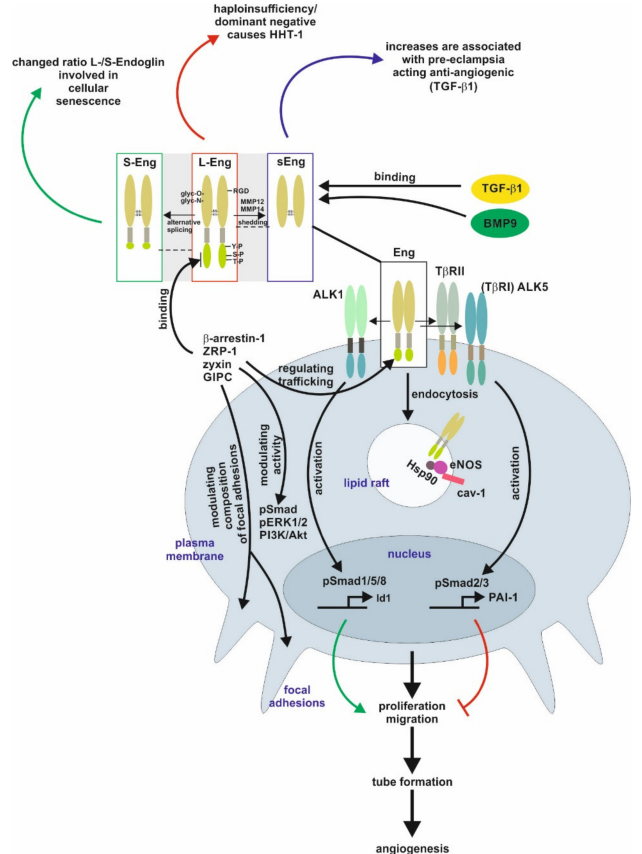
Figure 1. Endoglin biology in endothelial cells. (central part) Endoglin (Eng) is a component of a receptor complex in endothelial cells comprising the type I receptor dimers activin receptor-like kinase 5 (ALK5) or ALK1, and type II receptor dimers binding ligands, e.g., transforming growth factor- β 1 (TGF- β 1) and bone morphogenetic protein 9 (BMP9), of the TGF- β -superfamily. Interaction with these receptors either activates Smad1 / 5 / 8 or Smad2 / 3 signaling (phosphorylation) to regulate corresponding target genes, e.g., inhibitor of di ff erentiation 1 (Id1) and plasminogen activator inhibitor-1 (PAI-1), and finally, cellular responses including proliferation and migration to balance the activation and resolution phase of angiogenesis. Localization of Eng in caveolin-1 (cav-1) positive lipid rafts mediates interaction of heat shock protein 90 (Hsp90) with endothelial NO-synthase (eNOS) regulating its function. (upper part) Beside the long variant of Eng (L-Eng), a C-terminally truncated, shorter splice variant (S-Eng) and a shedded form, mediated by matrix metalloproteinase (MMP)-14, comprising only the extracellular domain (sEng) has been identified. All three variants of Eng are involved individually in cellular (senescence) and pathological conditions (e.g., HHT-1, pre-eclampsia), respectively. The extracellular domain of Eng is N - and O -glycosylated and human Eng contains an integrin binding motif (RGD) motif. The L-Eng C-terminal domain is a substrate for TGF- β receptors leading to serine / threonine phosphorylation. Tyrosine phosphorylation is mediated by Src. L-Eng interacts with its cytoplasmic domain with several intracellular proteins regulating receptor tra ffi cking, phosphorylation / activity of kinases, and focal adhesion amongst others. The functional di ff erence of S-Eng compared to L-Eng most likely arises from the missing binding- and phosphorylation-sites in its C-terminus. Abbreviations used are: GIPC, GAIP C-terminus-interacting protein; HHT-1, hereditary hemorrhagic telangiectasia 1; Smad, small mothers against decapentaplegic; pERK1 / 2, phosphorylated extracellular signal-regulated kinase 1 / 2; PI3K / Akt, phosphatidylinositol 3-kinase; T β RI / II, transforming growth factor- β 1 type I or II receptor; ZRP-1, zyxin-related